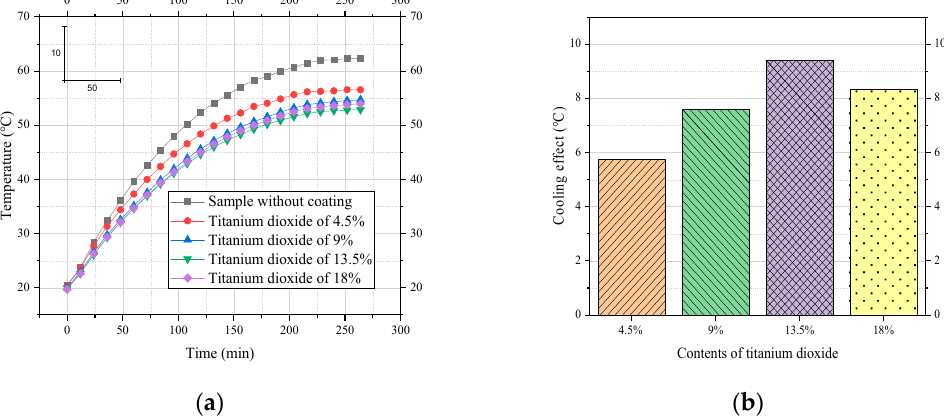
Figure 6. Effect of titanium dioxide on the cooling performance of coatings. ( a ) Process of heating to thermal equilibrium; ( b ) comparison of cooling effects.